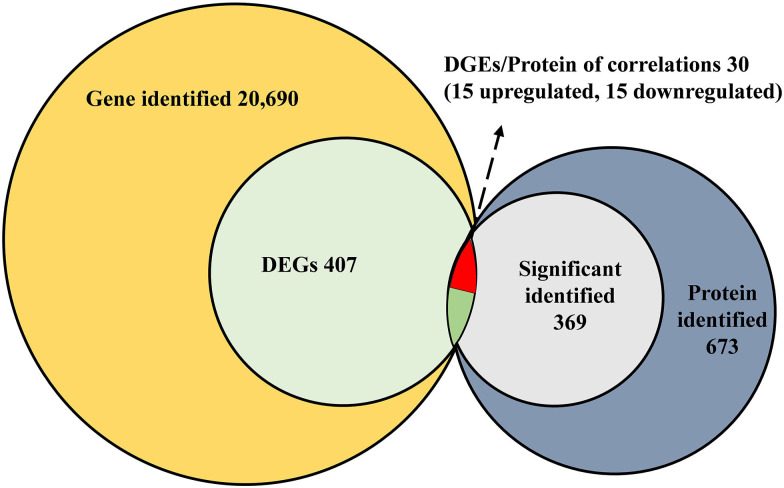
Correlated analysis between DEGs of RNA-seq and protein of shotgun. The local tBLASTp program was performed to analyze the correlation with an E-value less than 1.0E– 50 and a bit score >100.